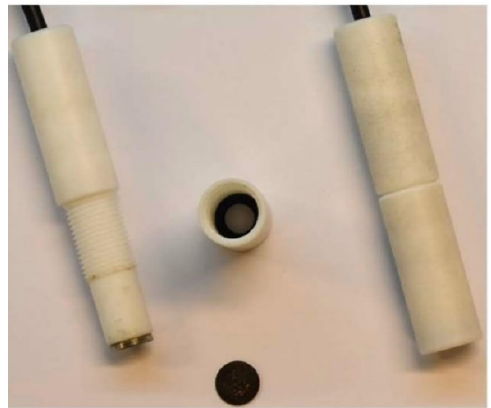
Figure 2. Digital picture of Electrode Body 1 (EB1).